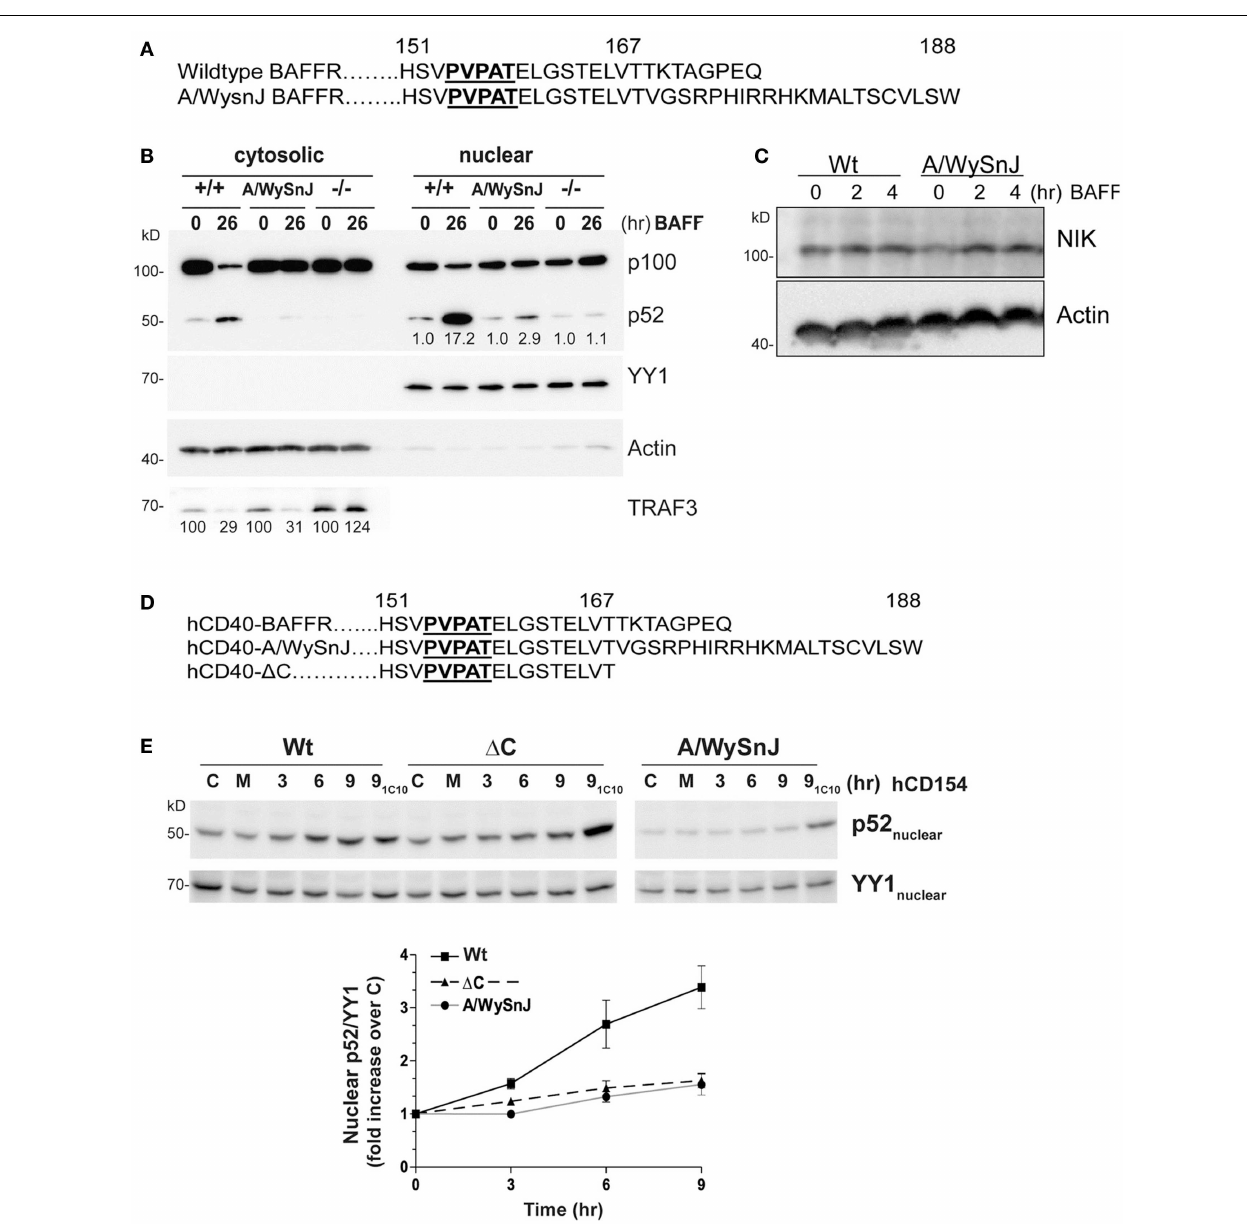
FIGURE 6 | Impaired NF- κ B2 activation induced by mutant BAFFRs . (A) Comparison of the C-terminal signaling domain amino acid sequences of Wt and A/WySnJ BAFFRs. Bold and underlined sequences indicate theTRAF3 binding motif, numbers above the sequences indicate the position of the amino acids. (B) Equal numbers of resting splenic B cells isolated fromWt ( + / + ), A/WySnJ, and BAFFR − / − ( − / − ) mice were stimulated with 100ng/ml of BAFF for 26h. Cytosolic and nuclear fractions were prepared and subjected to SDS-PAGE as in Section “Materials and Methods.”Western blots of samples were probed for p100/p52,TRAF3, actin, andYY1, as in Figure 1 . Numbers on theTRAF3 blot indicate mean values of the proportion of remainingTRAF3 relative to unstimulated controls of each genotype, from two independent experiments. Numbers on the blot of nuclear extracts represent averages